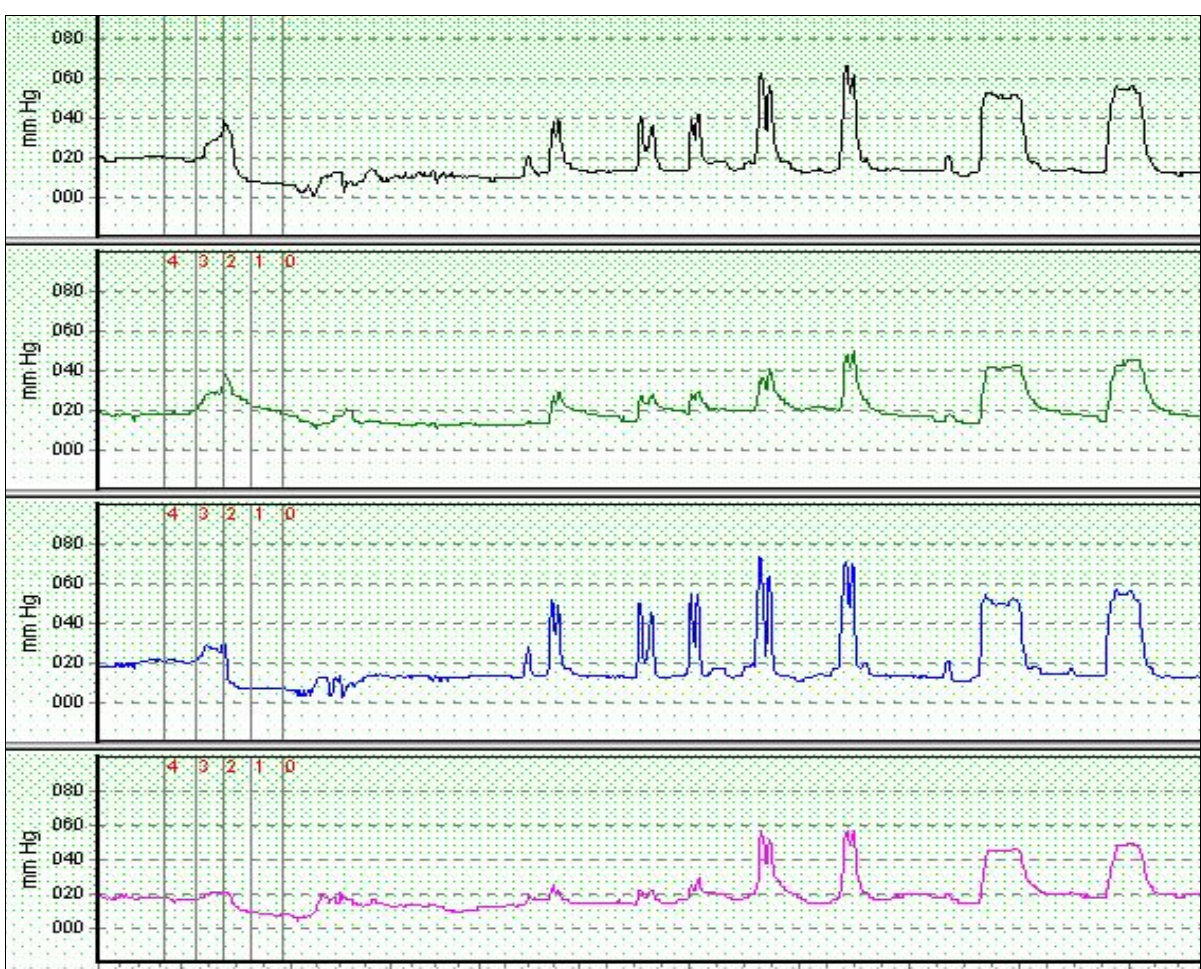
FIGURE 1 - Computarized anorectal manometry using the perfusion